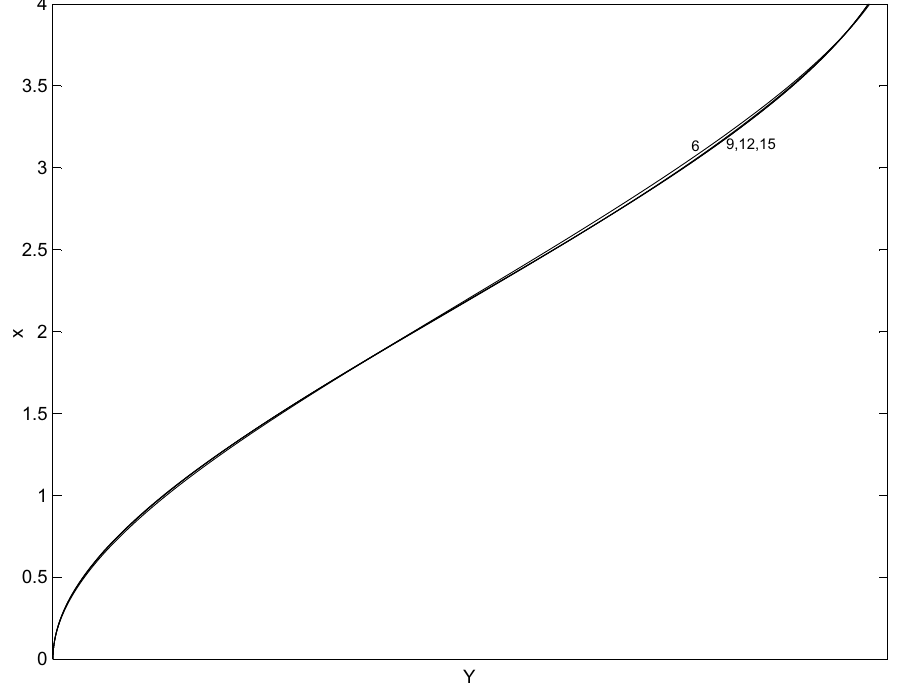
Fig. 10. Portal frame column RRMM first mode convergence (6, 9, 12, 15